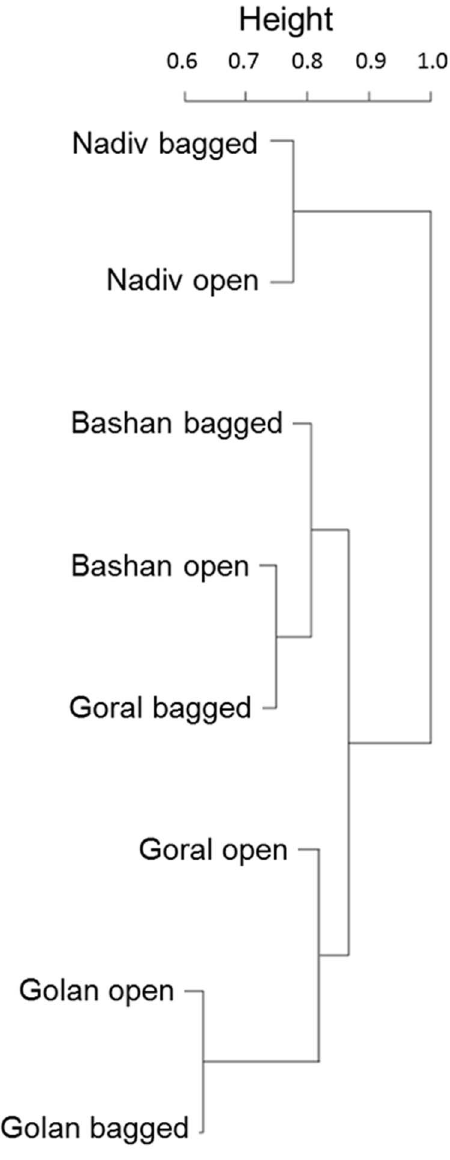
Figure 4. Nectar bacterial community composition clustered by site (Goral, Nadiv, Bashan and Golan) and treatments (open and bagged). Sites varied significantly in OTUs composition (Adonis test; F 3 =1.36, R 2 =0.5, P , 0.05; Table